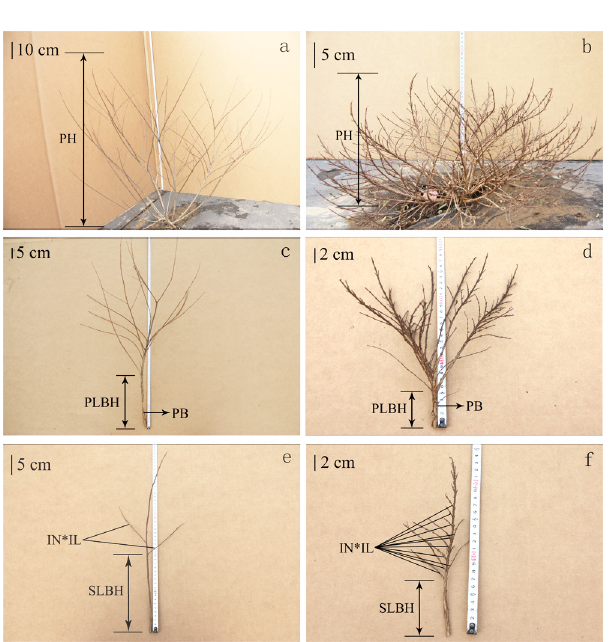
Fig 2. Pictorial representation of the phenotypic traits of dwarf and non-dwarf crape myrtle. PH, IL, IN, PLBH, SLBH and PBN represent plant height, internode length, internode number, primary lateral branch height, secondary lateral branch height and primary branch number, respectively. (a) PH for the non-dwarf phenotype, (b) PH for the dwarf phenotype, (c) PLBH and PB for the non-dwarf phenotype, (d) PLBH and PB for the dwarf phenotype, (e) IN, IL and PLBH for the non-dwarf phenotype, (f) IN, IL and PLBH for the dwarf phenotype.